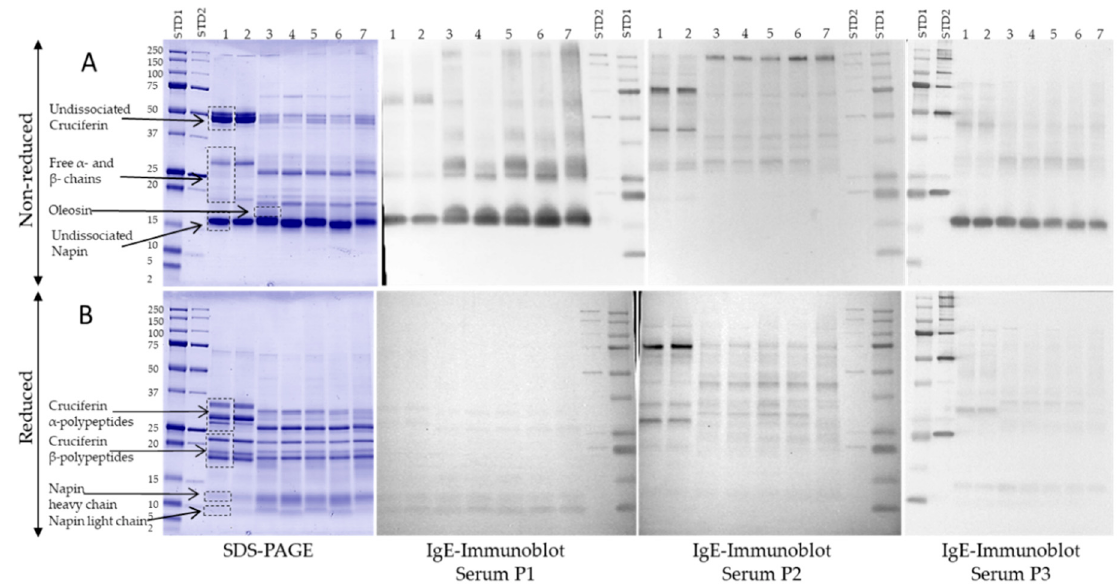
Figure 4. Protein and IgE- binding profiles of different mustard varieties. Carbonate mustard protein extracts were separated under non-reducing ( A ) and reducing ( B ) conditions. 1: S. alba AC Pennant; 2: S. alba Andante; 3: B. juncea Duchess; 4: B. juncea AC Vulcan; 5: B. juncea Dahinda; 6: B. juncea Centennial Brown; 7: B. juncea Cutlass; STD1 and STD2 are protein MW markers.